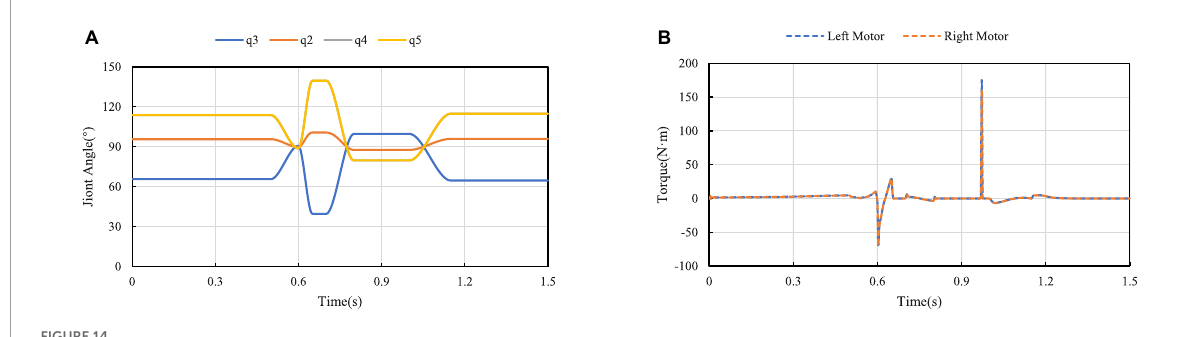
FIGURE14 Curve change of jump process: (A) Curve of joint angle change; (B) Output torque diagram of motors.